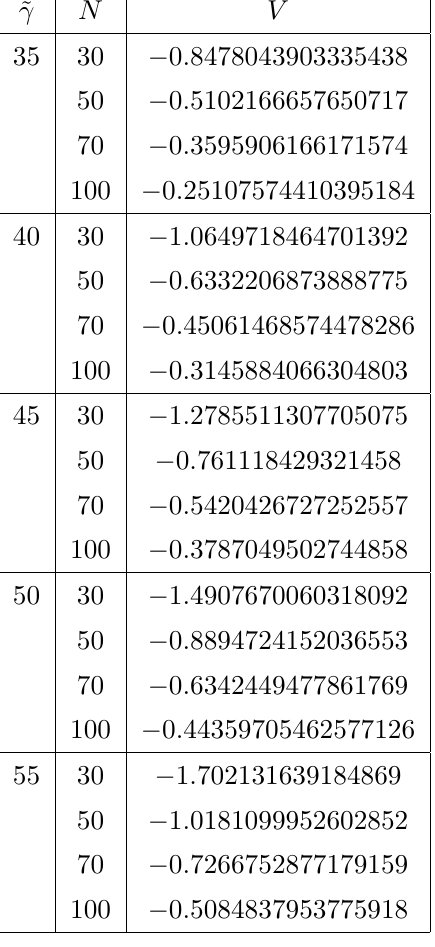
Table 1. N = 30 , 50 , 70 and 100 , partial phase, θ = 0